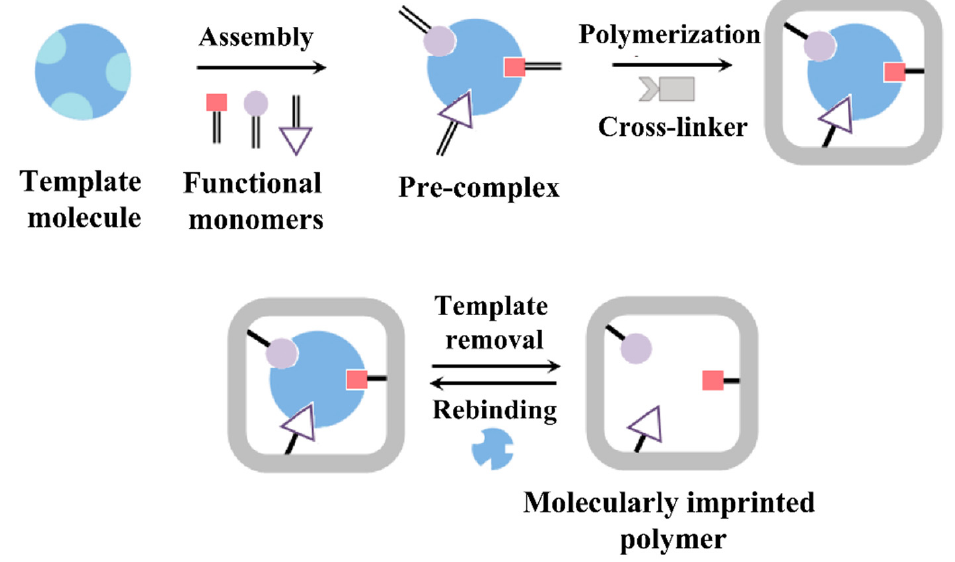
Figure 8. MIP receptors rely on the principle of host–guest chemistry. Functional monomers are polymerized in the presence of template molecules with which they form weak, sterically oriented bonds. After template extraction by organic solvents, the MIP cavities bind target molecules from aqueous media in a reversible fashion. Figure reprinted from ref. [175], open access article distributed under the terms and conditions of the Creative Commons Attribution (CC BY) license.